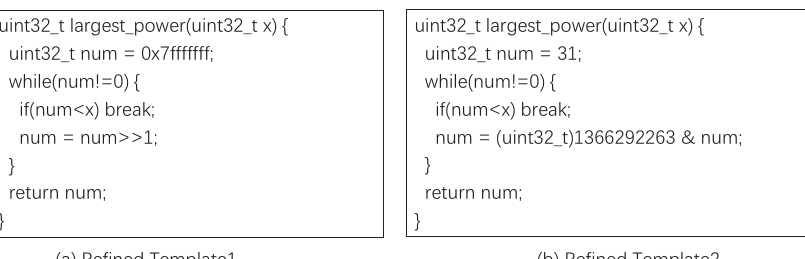
Figure 10. Original C code for computing a certain power of 2 and two templates.